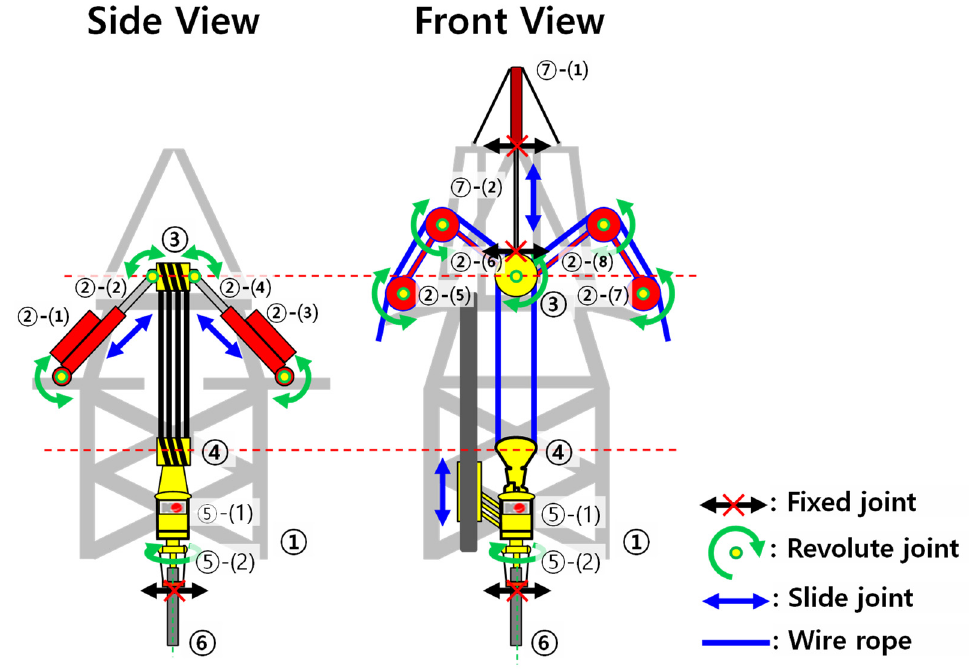
Figure 9. Mechanical configuration of the heave compensation